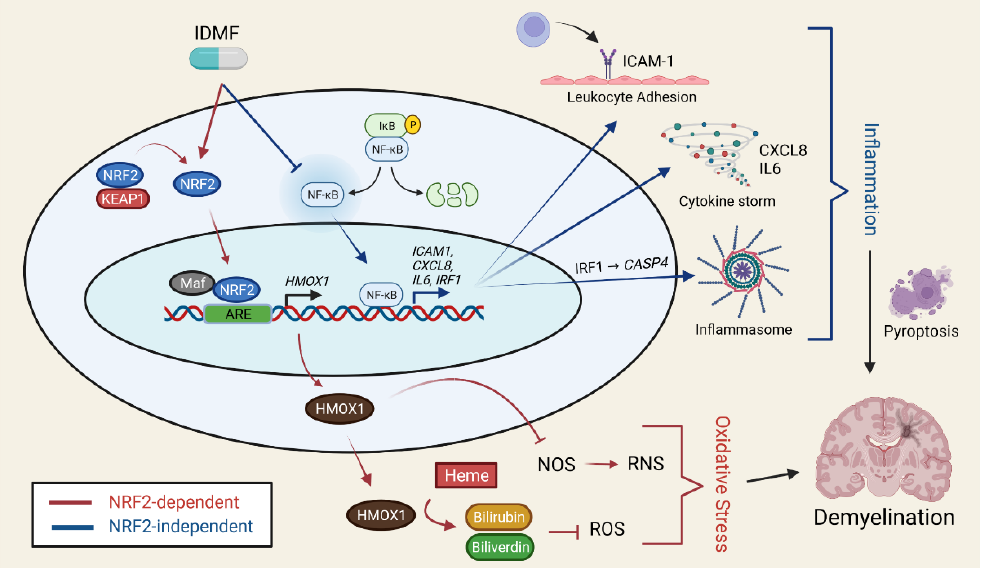
Figure 9. IDMF hypothesized mechanisms of therapeutic effect. IDMF activates NRF2-dependent signaling (red arrows) while inhibiting NF-κB activity and transcription of downstream genes (blue). IDMF triggers dissociation of NRF2 from KEAP1 to allow nuclear translocation of NRF2. Nuclear NRF2 dimerizes with musculoaponeurotic fibrosarcoma (Maf) and binds antioxidant response elements (ARE) to induce the transcription of target genes, such as HMOX1 . The HMOX1 protein then acts as an enzyme to catalyze the formation of antioxidants such as bilirubin and biliverdin, while also inhibiting nitric oxide synthase (NOS). Together, these effects of HMOX1 reduce accumulation of reactive oxygen and reactive nitrogen species (ROS and RNS) to attenuate oxidative stress. The inhibition of NF-κB by IDMF prevents nuclear translocation and up-regulation of target genes such as ICAM1 , CXCL8 , IL6 , and IRF1 . Reduced expression of these targets leads to reduced inflammation via attenuation of ICAM1-dependent leukocyte adhesion, cytokine production with cytokine storm, and IRF1/ CASP4 -dependent inflammasome activation. Overall dampening of these inflammatory processes inhibits pyroptosis and, thus, limits progression of demyelination. See text for details. (Figure created with BioRender.com). Table 1. Summary table. The table lists the number of DEGs identified ( p < 0.05 with FC > 1.25 or FC < 0.80), top biological process (BP) terms most strongly enriched among DEGs, top sequence motifs enriched in DEG 5 kb upstream regions, DEGs correspondingly regulated by NRF2 and niacin, DEGs inversely regulated by NF-κB, IRF factors associated with enriched motifs in DEG upstream regions, A1 astrocyte marker down-regulated DEGs, MS-associated DEGs, and DEGs near MS GWAS loci. Results are summarized for increased DEGs ( ▲) , decreased DEGs ( ▼) , and the com- bined set of increased and decreased DEGs ( ▲ + ▼) . See footnotes for further details.